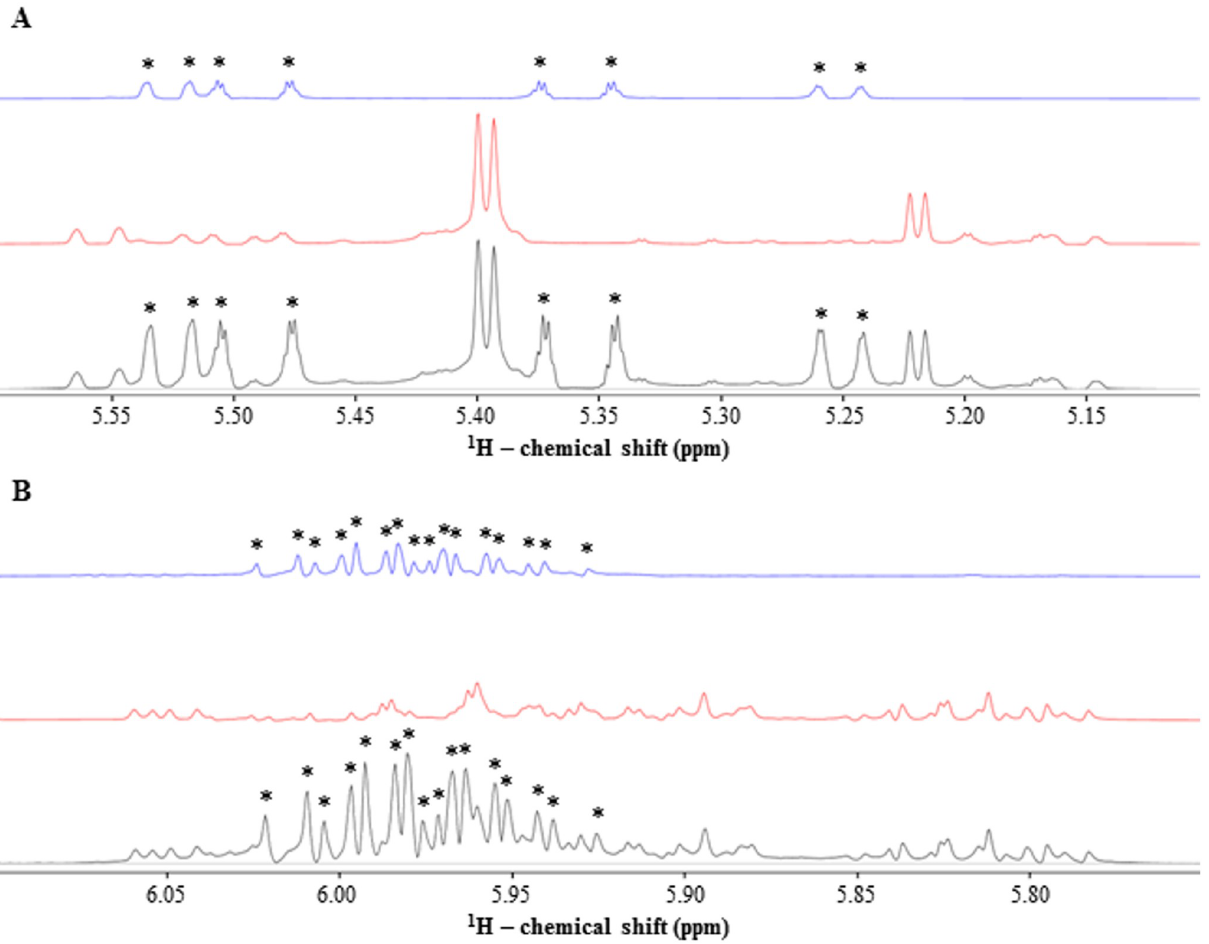
Fig 1. 1 H NMR analysis of ES-GBBr formulation fractions establishes presence of unknown compound(s). Stacked 1D 1 H NMR spectra (600 MHz, 10% D 2 O) in chemical shift regions (A) 5.1–5.6 ppm and (B) 5.75–6.1 ppm for ES-GBBr SM (black), SM-P (red), and SM-NP (blue) fractions. Asterisks indicate NMR signals from molecule(s) of